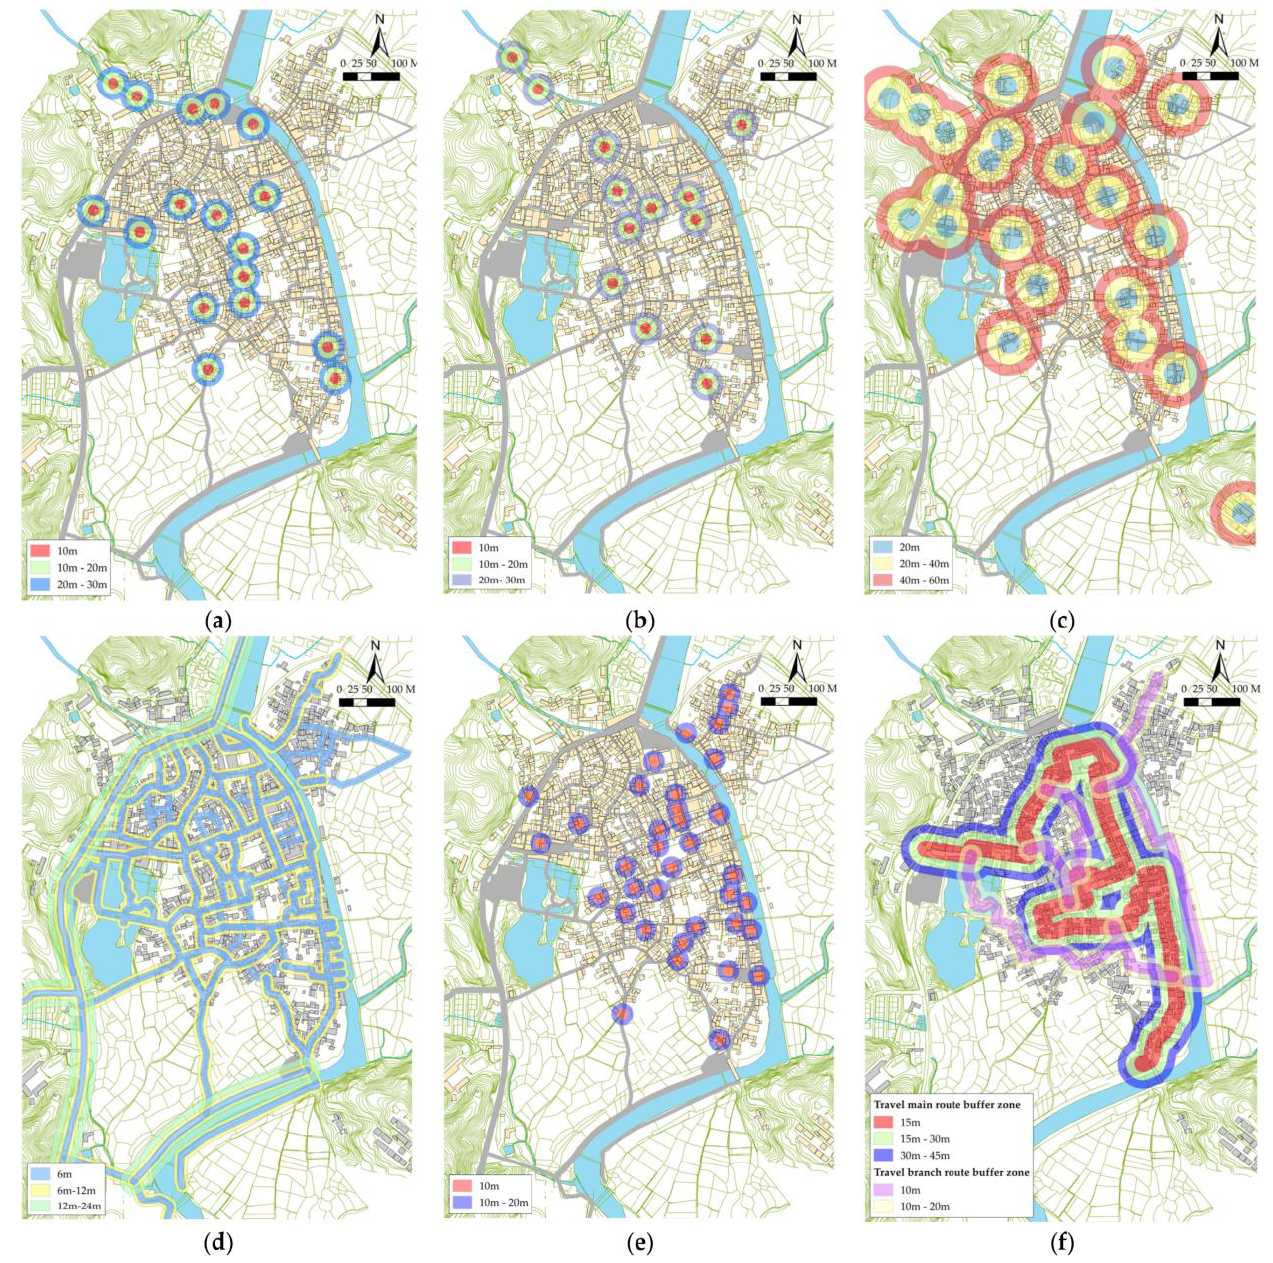
Figure 11. Establishment of the index buffer zone. ( a ) Moving ember buffer zone; ( b ) electric box buffer zone; ( c ) hydrant buffer zone; ( d ) micro fire engines buffer zone; ( e ) occupant gathering point buffer zone; ( f ) travel route buffer zone.